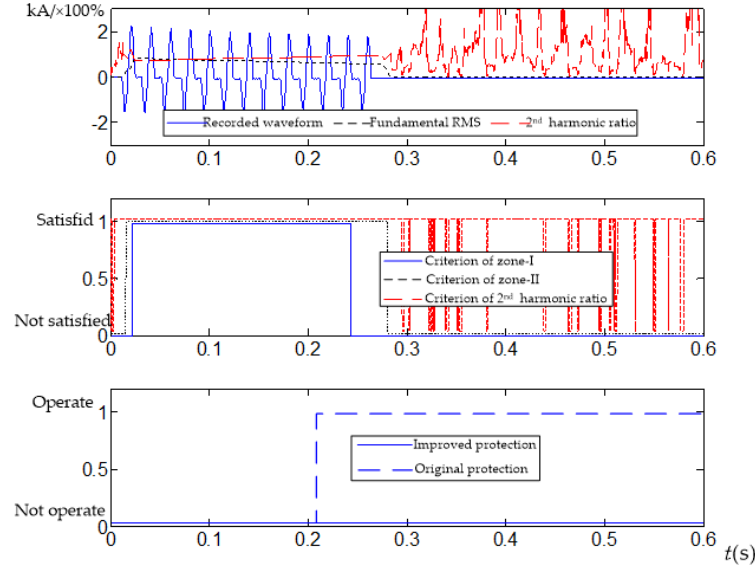
Figure 13. Protection behavior of waveform Number Two 1 .